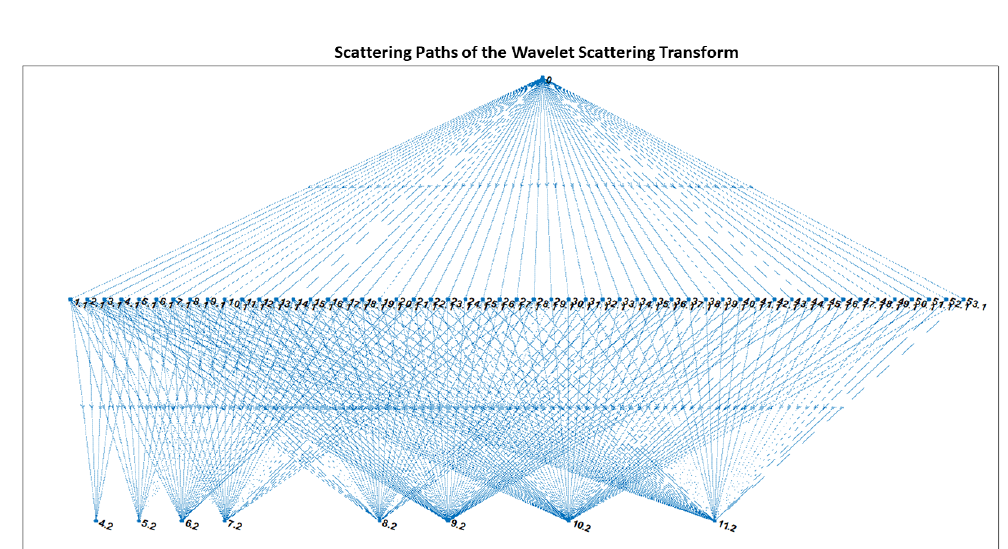
Figure 19. The wavelet scattering network’s paths based on the invariance scale, signal input length, and sampling